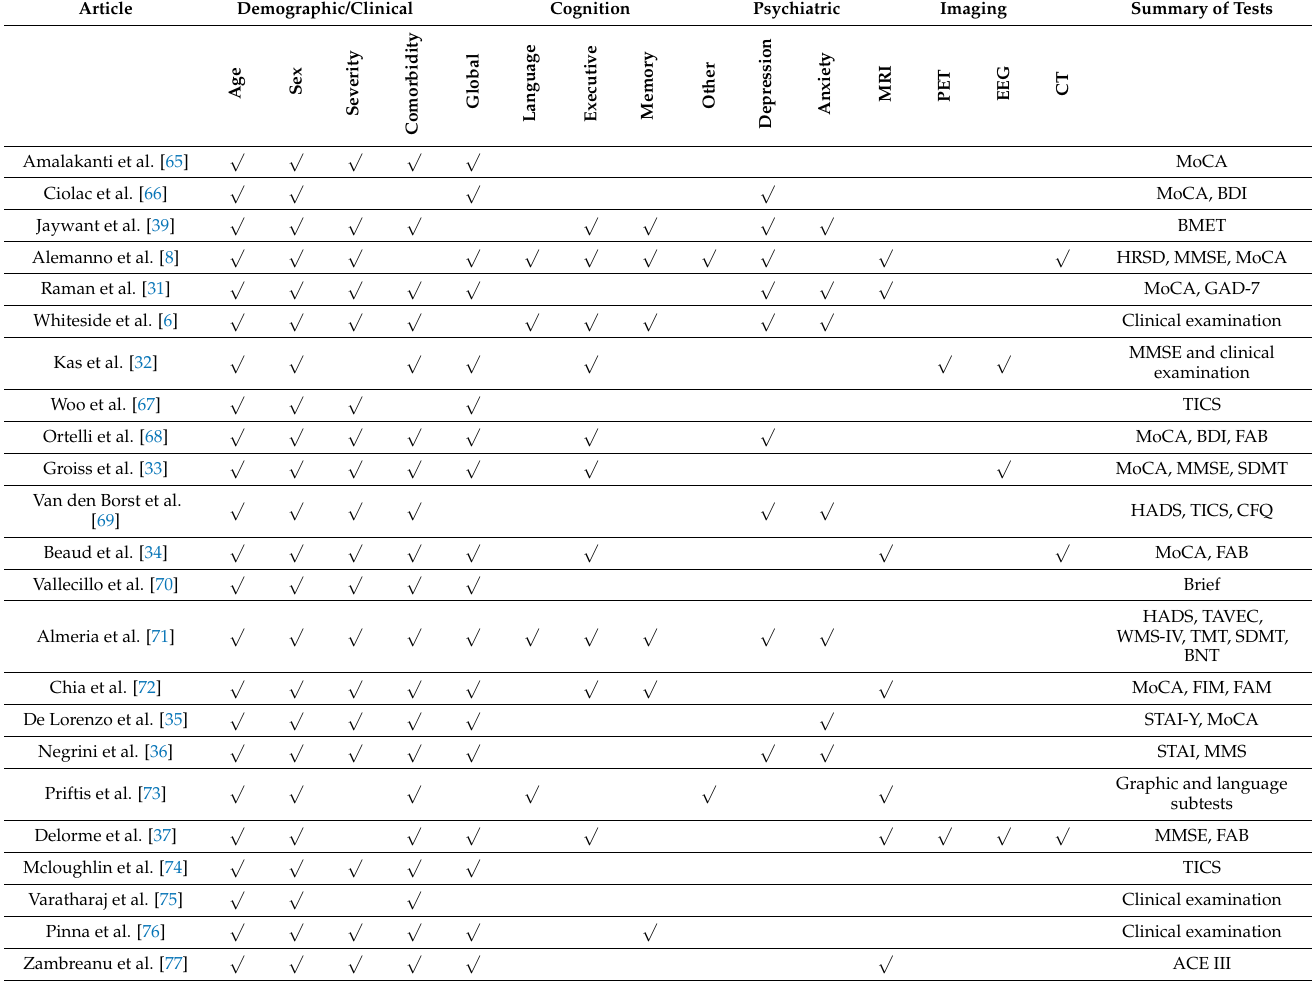
(11/15), followed by CT (6/15), EEG (5/15), and PET (4/15) (see Table 2). Table 2 indicates the presence or absence of psychiatric, neurological and cognitive measures in each of the 48 articles. It should be noted that methods or tools that were only used in a single study are not listed. Table 2. Parameters yielded by literature